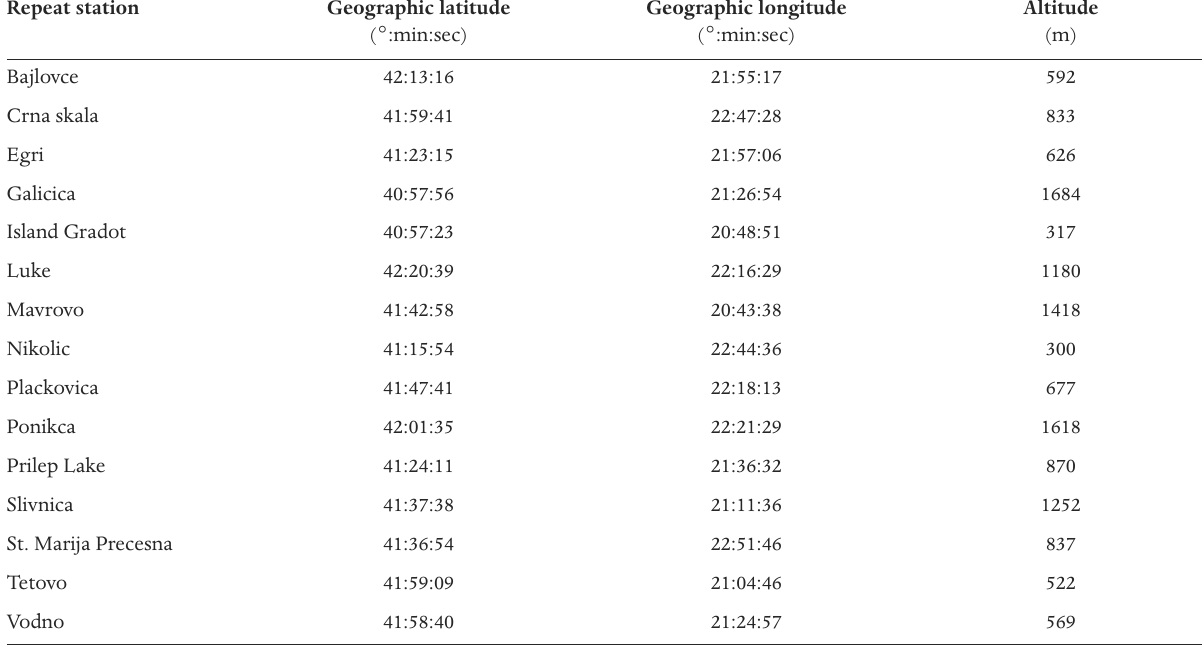
Table 1. GPS coordinates of the repeat